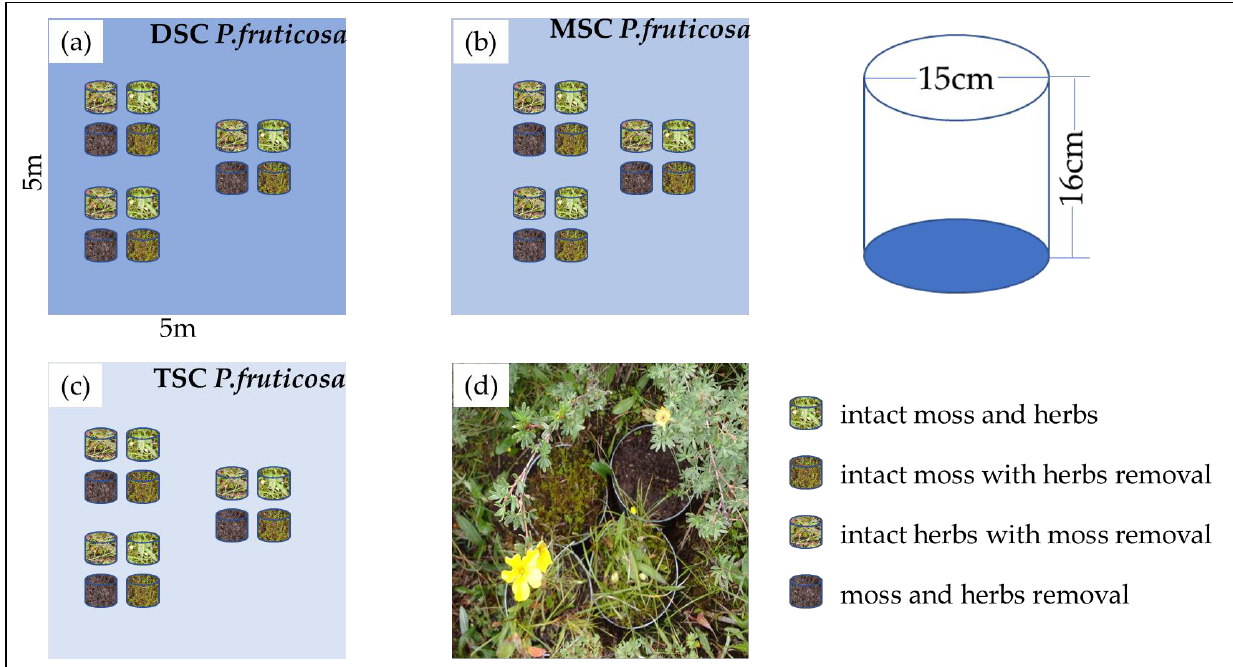
Figure 5. The design graph of the lysimeter evapotranspiration experiment. Three repeated treatment groups were set in each plot: dense shrub cover (DSC) ( a ), medium shrub cover (MSC) ( b ), thin shrub cover (TSC) ( c ), and a photograph of lysimeters under a P. fruticosa canopy ( d ). Four lysimeters were used with the following treatments: intact moss and herbs, intact moss with herb removal, intact herbs with moss removal, and moss and herb removal.